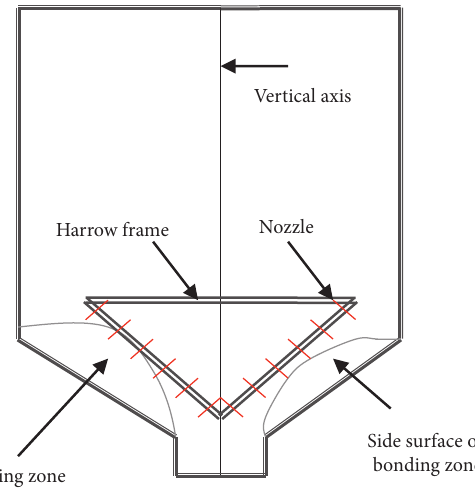
Figure 4: Simple view of the arrangement of spray nozzles.